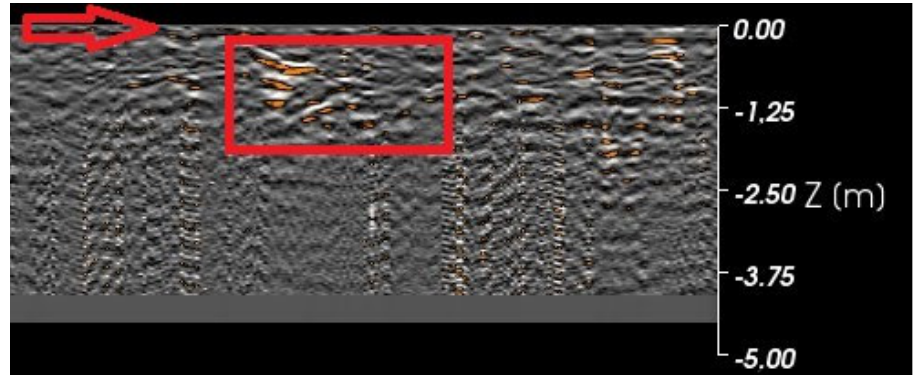
Figure 5. Radargram image. Section describing the alteration corresponding to the linear signal located to the northwest of the archaeological site.